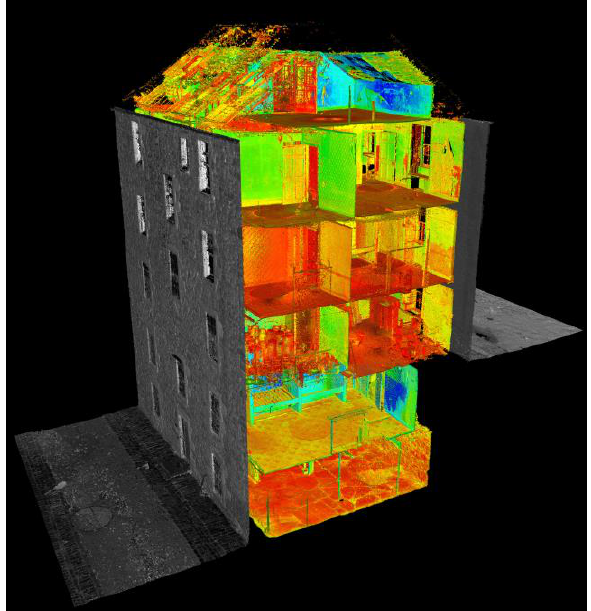
Figure 4. Point cloud image of the ‘Museum Stair’ building within New Lanark village © CDDV 2013.